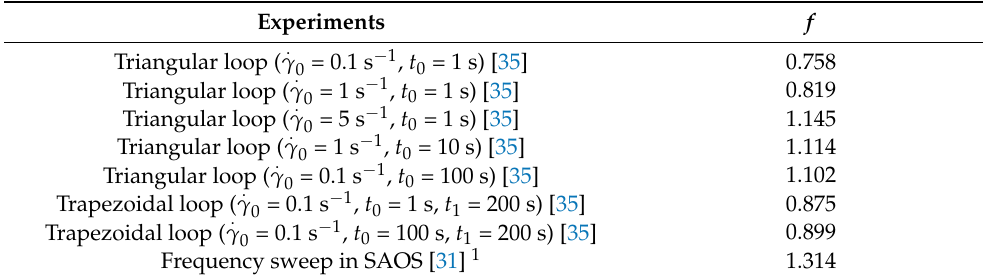
Table 4. Parameter f used in Equation (9) for discerning the obvious experimental